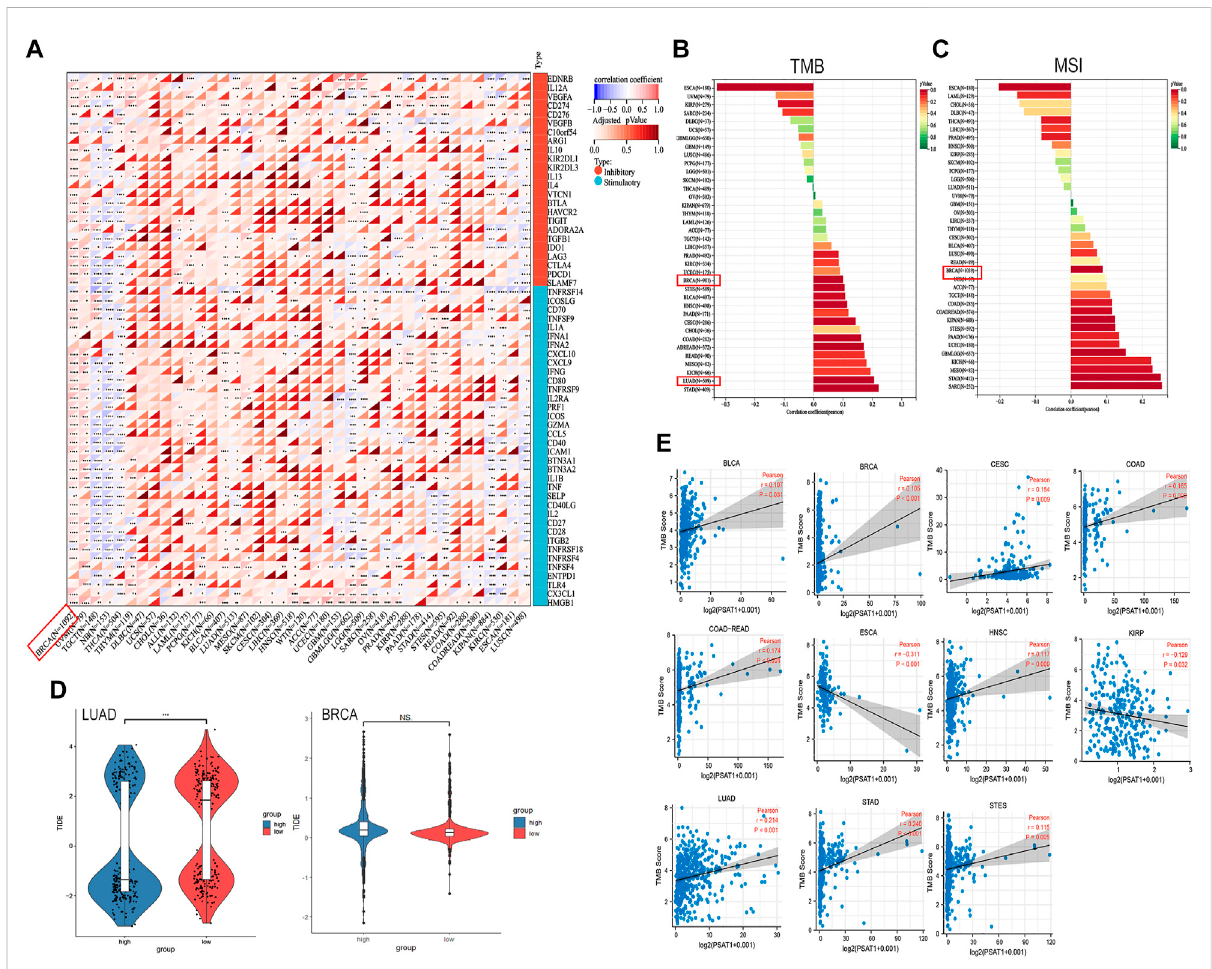
FIGURE 8 Correlation analyses of the PSAT1 expression with immune checkpoint genes, TMB, MSI and TIDE score. (A) Correlation analyses of the PSAT1 expression with immune checkpoint genes in pan-cancer. * p < 0.05 (B) A bar chart showing the association between PSAT1 expression and TMBinpan-cancer (C) AbarchartshowingtheassociationbetweenPSAT1geneexpressionandMSIinpan-cancer (D) TidescoreinLUADandBRCA, *** p < 0.001 (E) Cancer species with signi fi cant correlation between PSAT1 and